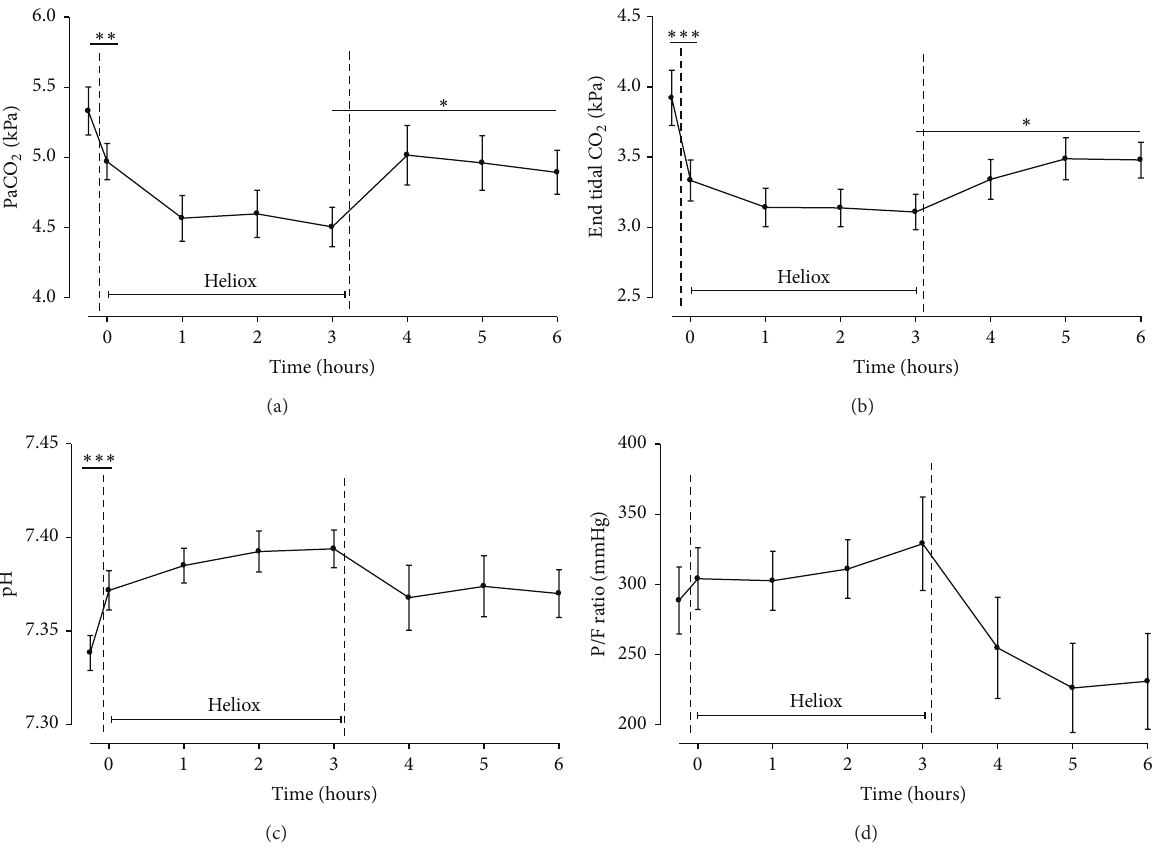
Figure 2: Gas exchange during ventilation with heliox for 3 hours ( 𝑇 = 0 to 𝑇 = 3 ). Measurements started just prior to heliox administration ( 𝑇 = −1 ) until 3 hours after heliox discontinuation ( 𝑇 = 3 to 𝑇 = 6 ). Data are means ± SEM. (a) PaCO 2 (kPa); (b) end tidal CO 2 measurements (kPa); (c) pH measured hourly; and (d) PaO 2 /Fi O 2 ratio (mmHg). ∗ : 𝑃 < 0.02 ; ∗∗ : 𝑃 < 0.01 ; ∗ ∗ ∗ : 𝑃 < 0.001